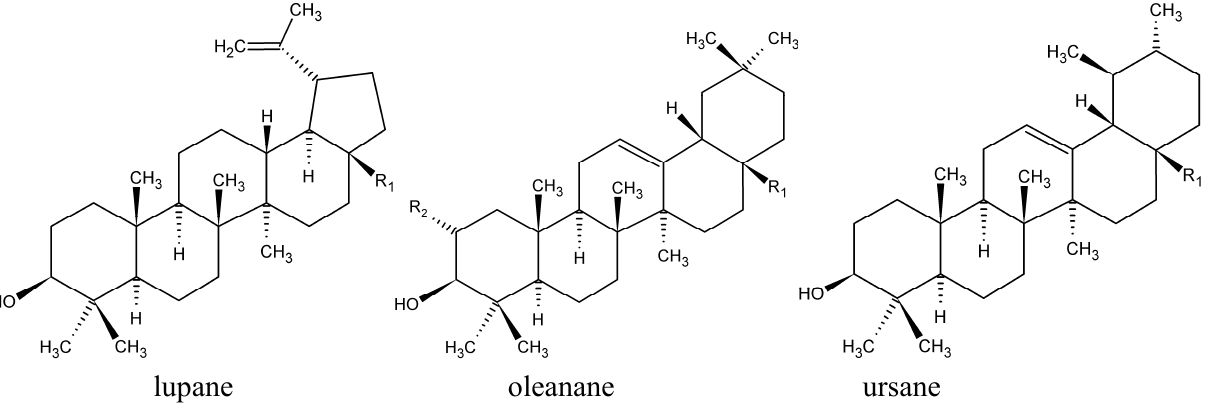
Figure 1. Molecule structures of lupane-, oleanane- and ursane triterpenes investigated here.